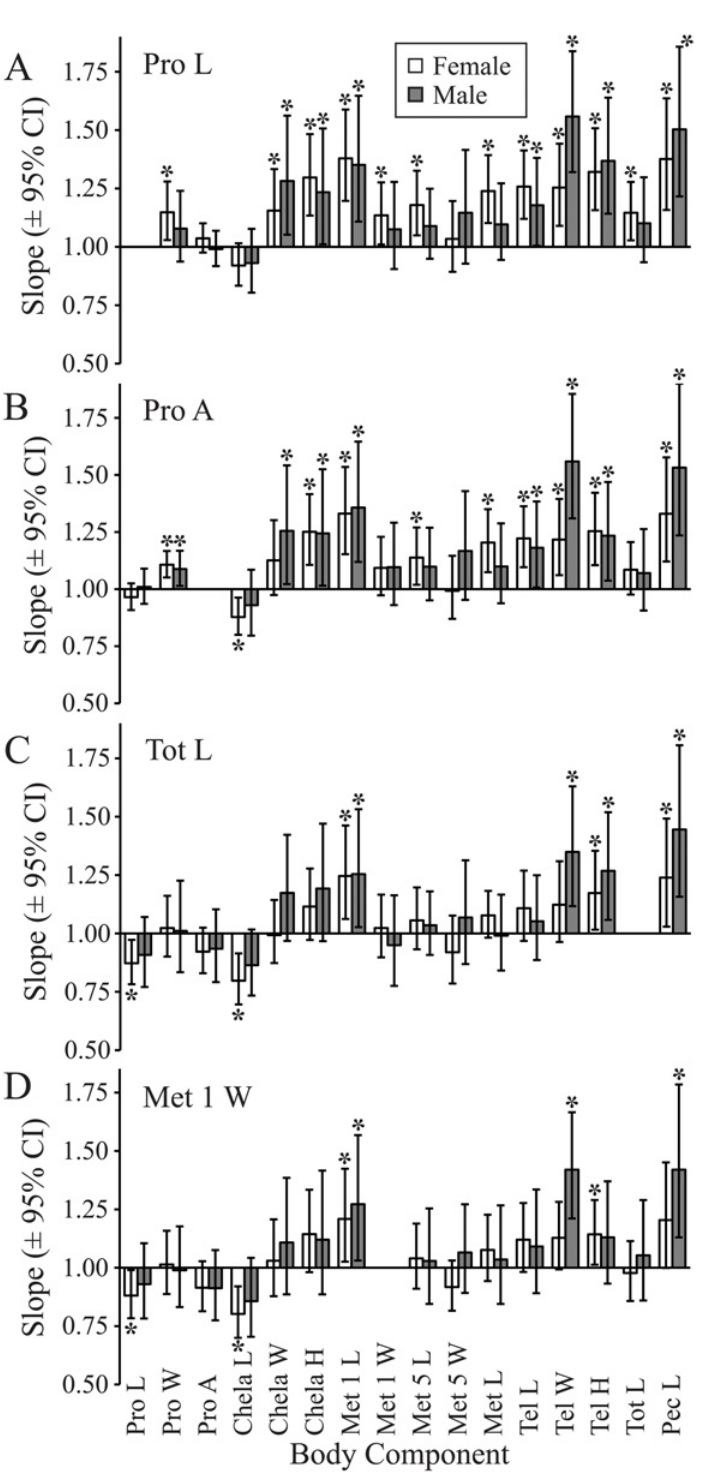
Fig 3. Effects of reference character on allometric trends of body components. Allometric slopes ( ± 95% CI) determined from four alternative reference characters are paired against each of 16 y-axis characters for females (N = 84 – 90) and males (N = 65 – 83). The reference characters included A: prosoma length (Pro L); B: prosoma area (Pro A); C: total length (Tot L); and D: metasoma segment 1 width (Met 1 W). Bars identified with an asterisk ( * ) indicate a significant difference between the slope and null hypothesis